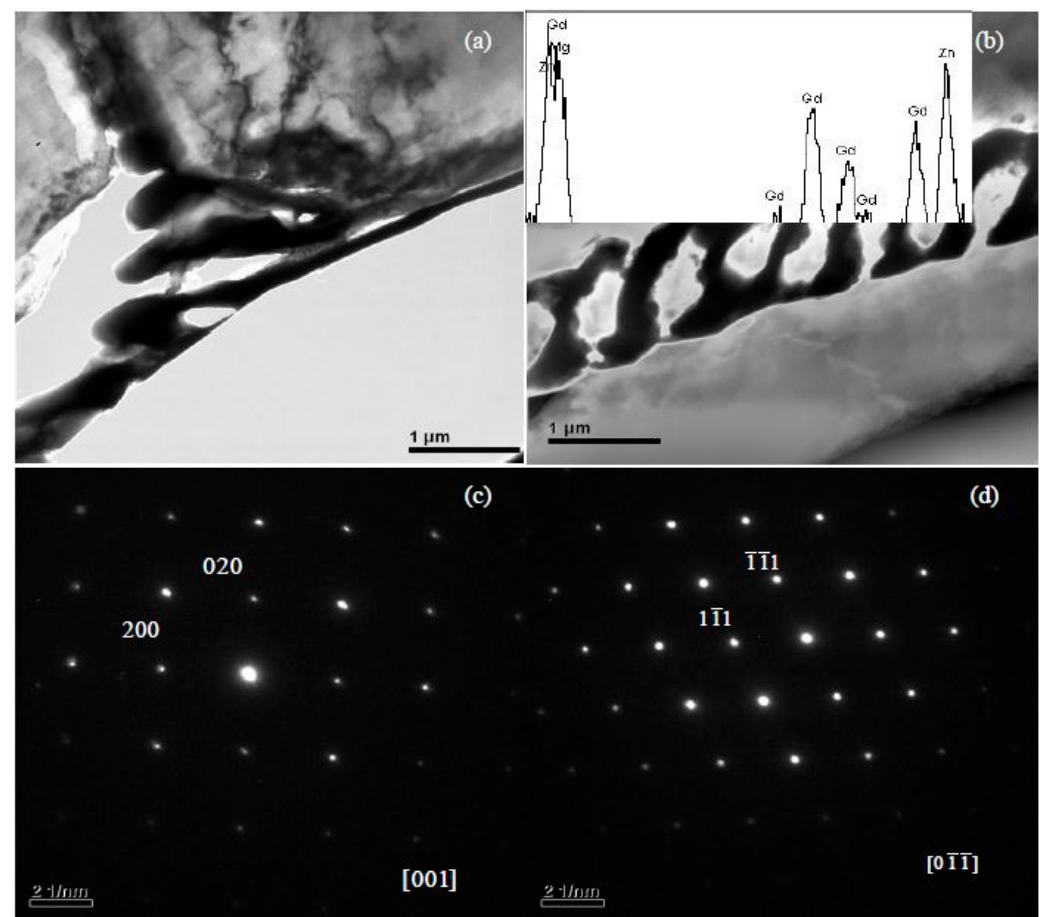
Figure 7. Identification of W-phase with by TEM in Mg-1Zn-1Gd alloy (Sample 36): ( a ) BF image for dendritic shape, ( b ) BF image for twist-like shape, ( c ) SAED pattern along [001] zone axis, and ( d ) SAED pattern along [ 011 ] zone axis. The W-phase in ( b ) has a composition of approximate Mg 36.4 Zn 35.76 Gd 27.84 (Zn/Gd = 1.3, at.%) and a lattice parameter a = 0.7256 nm.